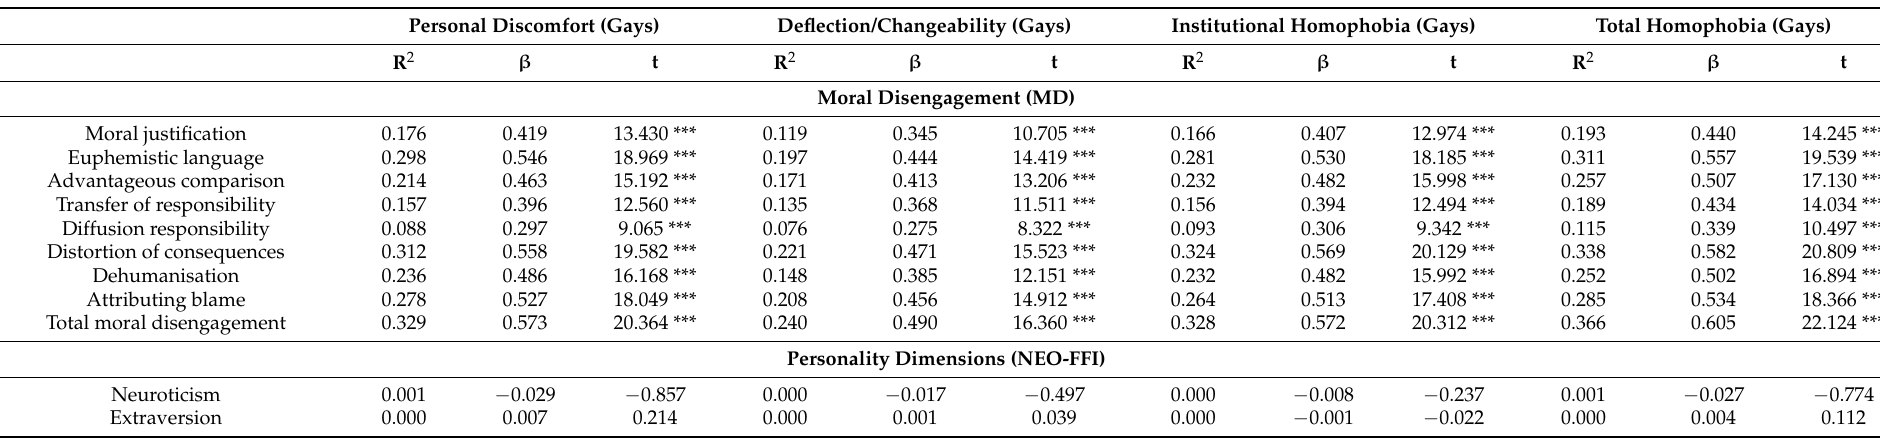
Table 3. Linear regression of modern homophobia towards the gay collective with respect to moral disengagement and personality